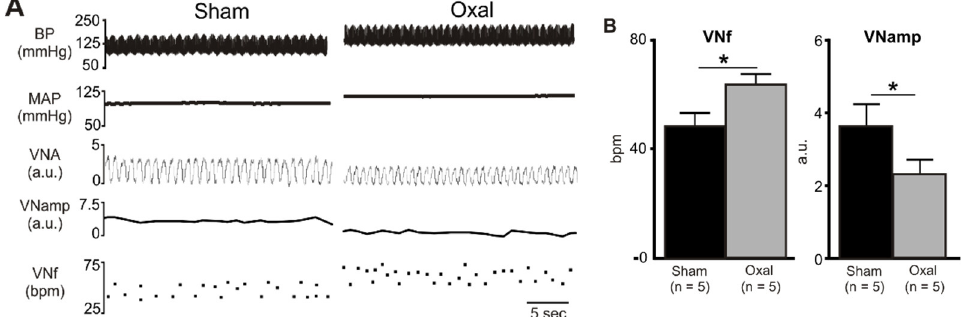
Figure 5. Effects of chronic oxaliplatin treatment on cholinergic nerve activity. ( A ) A representative recording of blood pressure (BP) (pulsatile and mean), vagus nerve activity (VNA) (rectified) [arbitrary units (a.u.)], vagus nerve amplitude (VNamp), and vagus nerve frequency (VNf) in vehicle-treated and chronic oxaliplatin-treated rats. ( B ) Grouped data of basal VNf and VNamp in vehicle-treated and oxaliplatin-treated rats. Effects are shown as absolute (VNf (bpm, bursts per minute)) or arbitrary (VNA, VNamp) values. Data are presented as the mean ± SEM. The number of animals is shown in parentheses. * p < 0.05 compared to the vehicle-treated group.